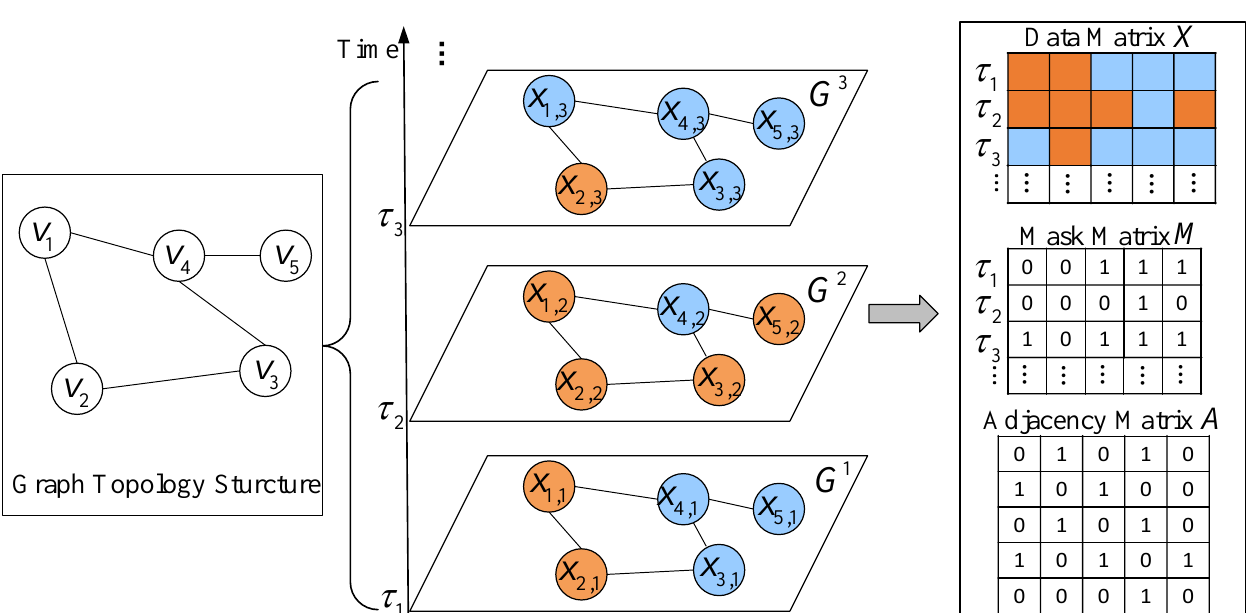
Figure 5. The graph structure of satellite data, where orange color represents missing data, blue color represents observed data, and solid line indicates that two nodes are spatially